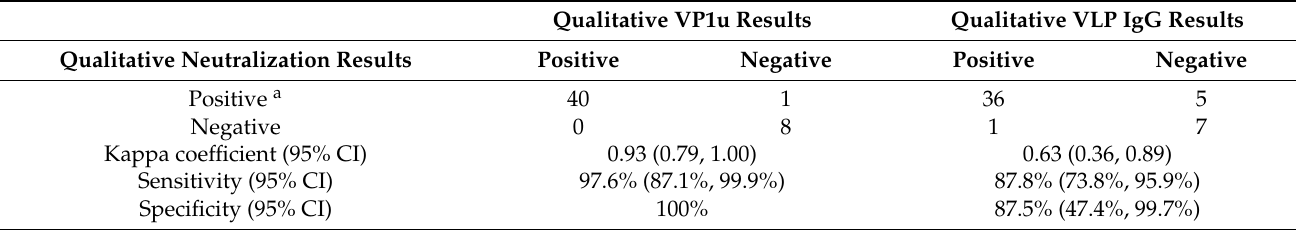
a Serum samples were obtained from patients 120 days after hospitalization for acute parvovirus B19 infection or from additional patients who were not experiencing aplastic